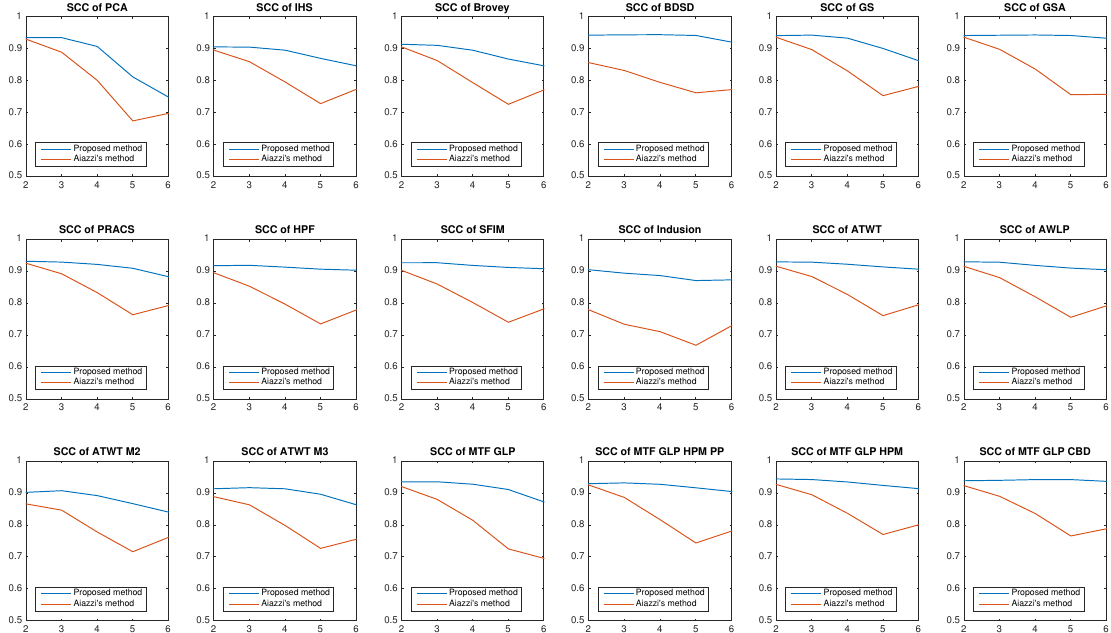
Figure 4. Spatial correlation coefficient (SCC) scores of fused image sequences constructed following Aiazzi’s method and MSD4FV.